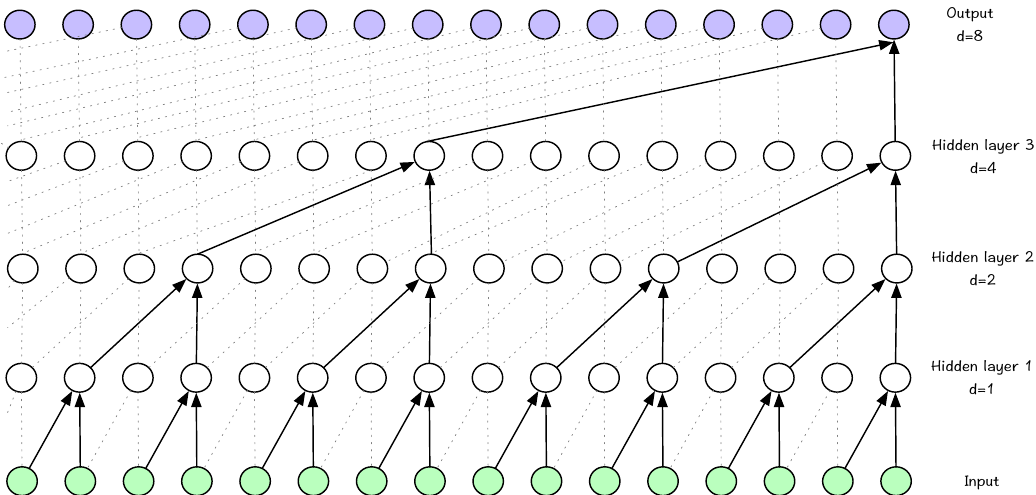
Figure 6. Dilated casual convolution with kernel size 2. With dilation factor d , it performs a standard 1D convolution on the selected sequence that is picked from the input every d